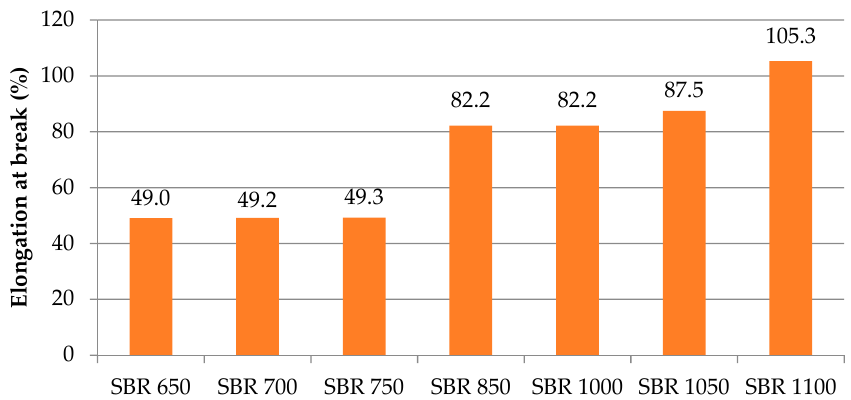
Figure 7. Tensile strength depending on the elastomeric material density.